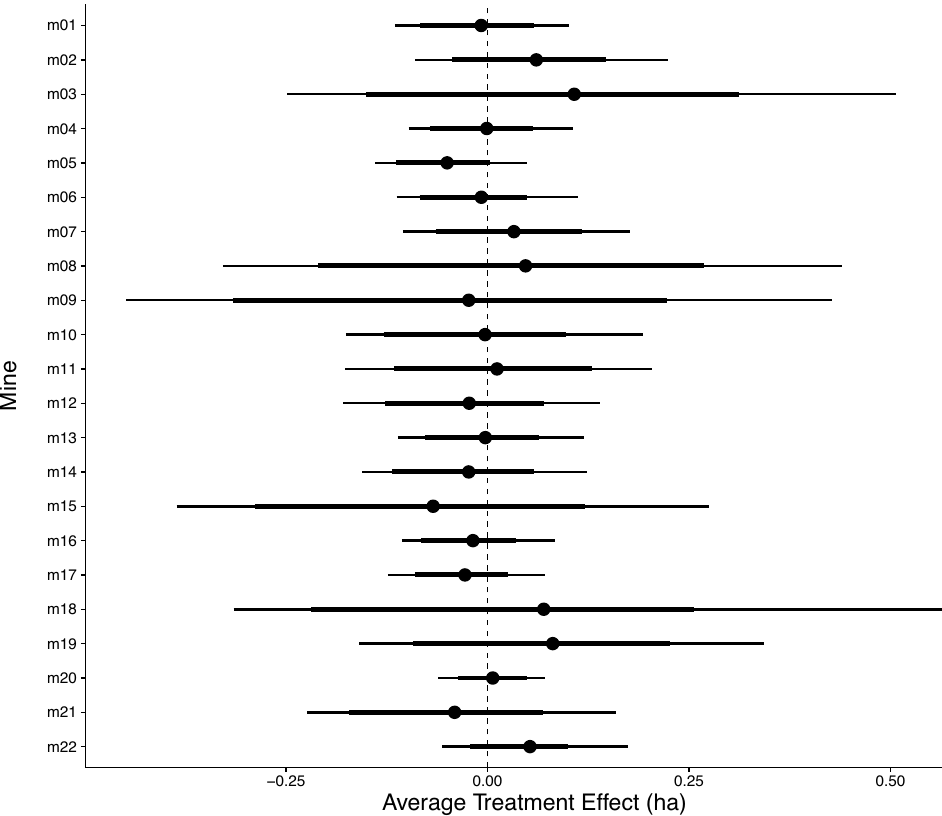
Figure 3. Estimated average treatment effect of mine establishment across all 5 years for each mine (except mine 22 which was established only three years before 2019 the last year of deforestation data). The effect is the difference in the area of tree canopy lost in hectares between the treatment and control areas. Estimates are from spatiotemporal models with a zero-inflated negative binomial error structure implemented in a Bayesian modelling framework using R-INLA (see Methods). Points are estimates of the mean of the posterior distribution, thick lines are the 80% credible intervals (calculated as the highest posterior density interval) and thin lines the